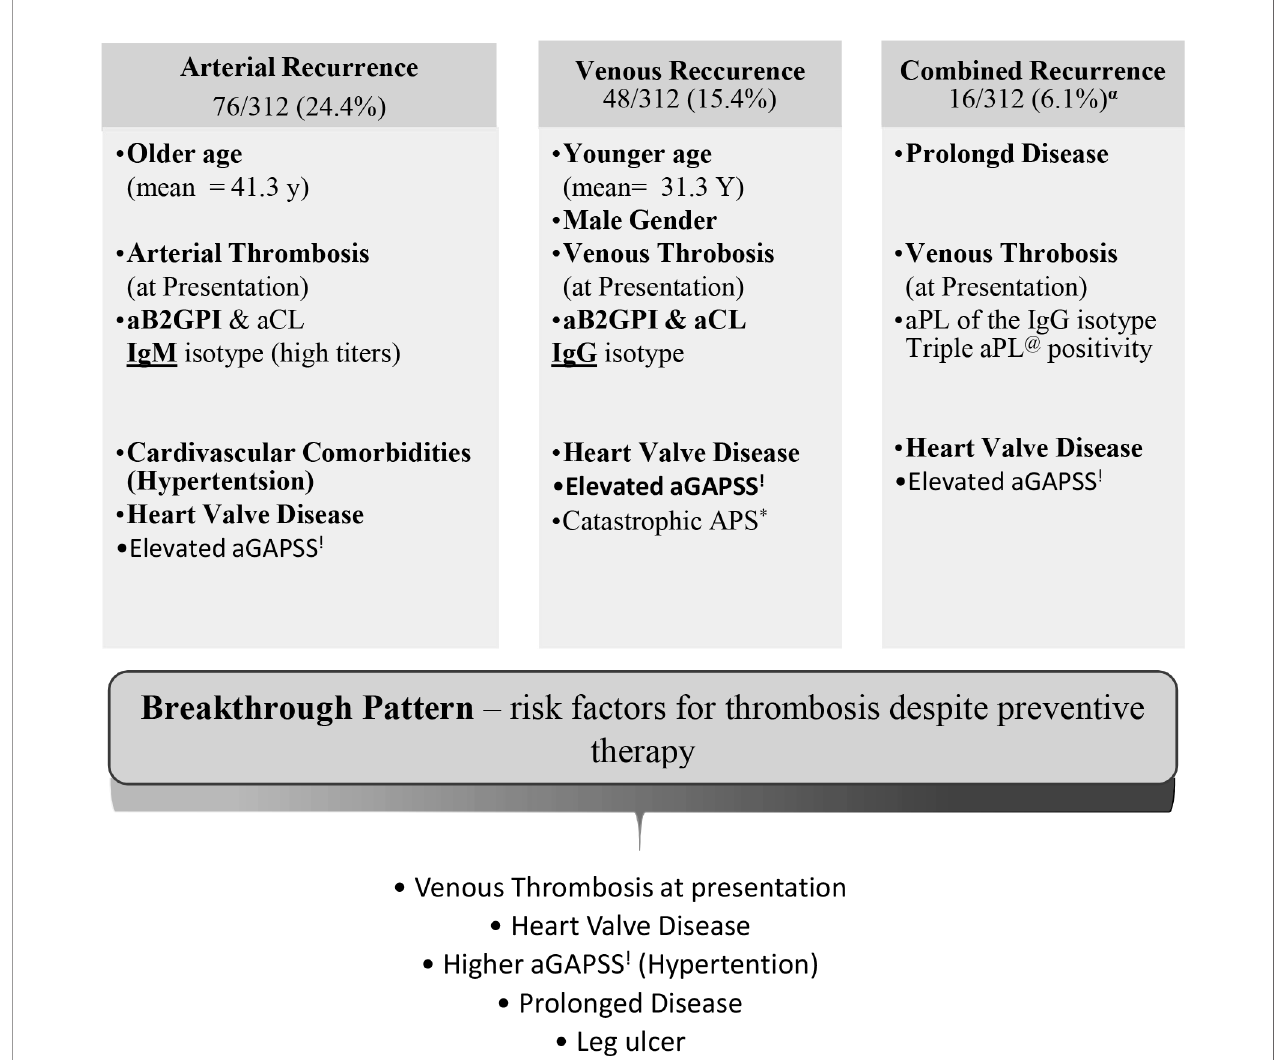
FIGURE 1 | Patterns of thrombotic recurrence in the primary Antiphospholipid Syndrome (n=143). All patients with at least one thrombotic event after established antiphospholipid syndrome. a Subset of patients with multiple types of thrombosis (i.e., arterial and venous; arterial and obstetric; venous and obstetric; arterial, venous and obstetric). *Antiphospholipid. @ Antiphospholipid antibody. ! Adjusted Global Antiphospholipid